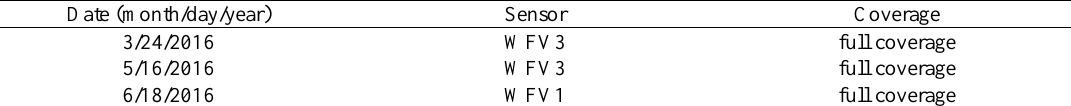
Table 1. Main parameters of GF – 1